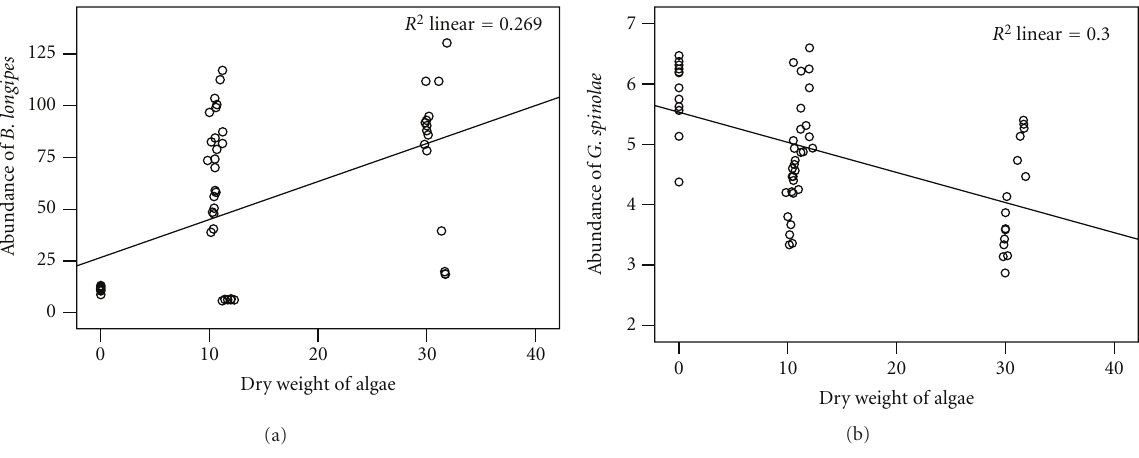
Figure 7: Relation between dry weight of algae (g/sq. m) and abundance of (a) Brachydeutera longipes (Hendel) and (b) Gerris spinolae (Lethierry and Severin) as shown by regression